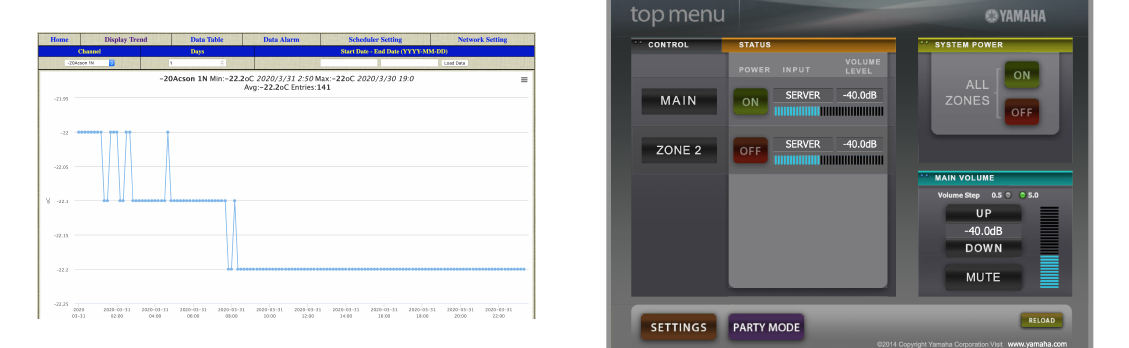
Figure 11. Screenshots of open WebIOPi ( left ) and Yamaha ( right )